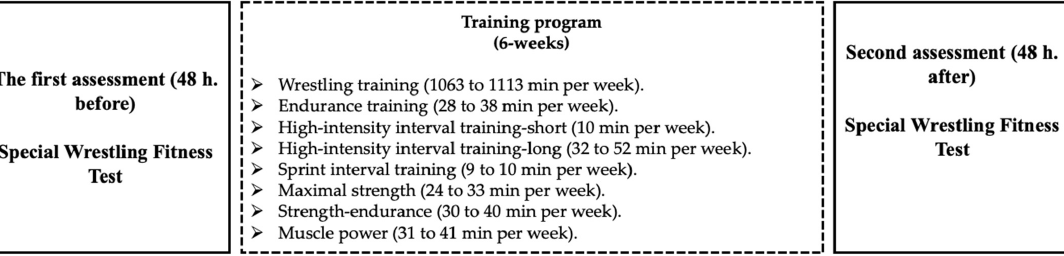
Figure 1. Experimental design.